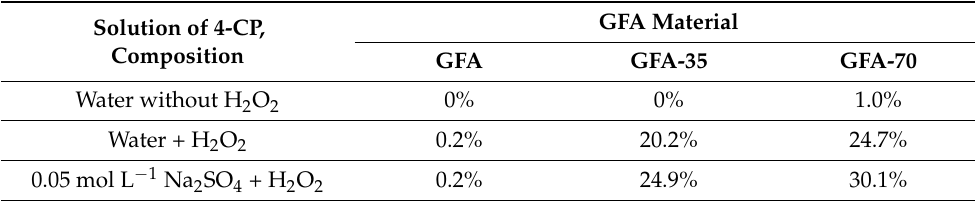
Table 9. The percentage removal of 4-chlorophenol after 6 h. Solution of